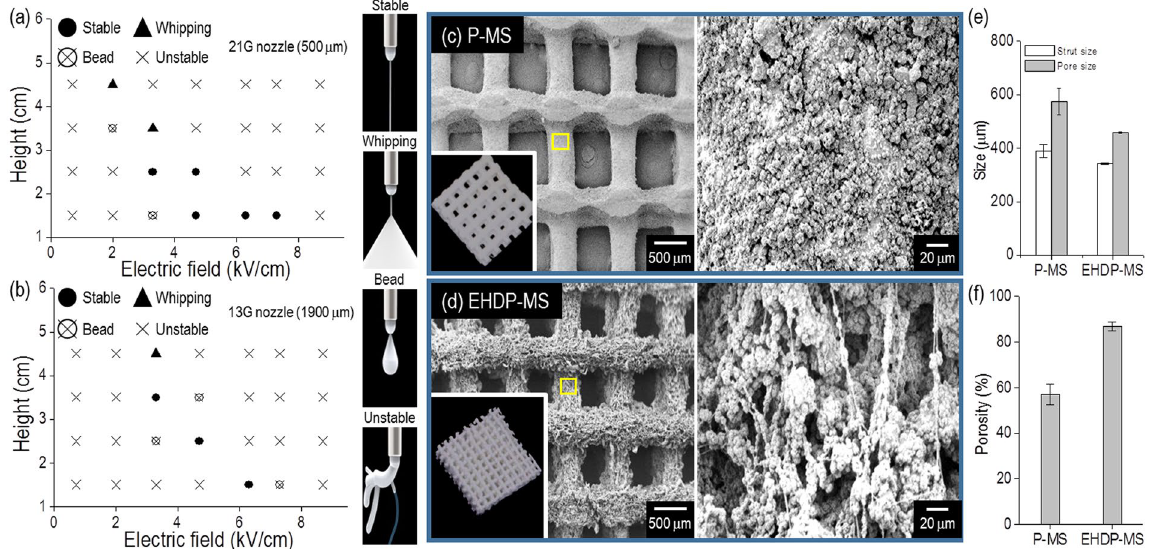
Figure 7. Processing window showing stable processing region for two nozzle diameters ( a ): 500 μ m and ( b ): 1900 μ m. SEM images of fabricated ( c ) P-MS and ( d ) EHDP-MS structures with slightly different strut diameters and pore sizes. ( e ) Average size of strut and pore and ( f ) porosity of the fabricated mesh structures.